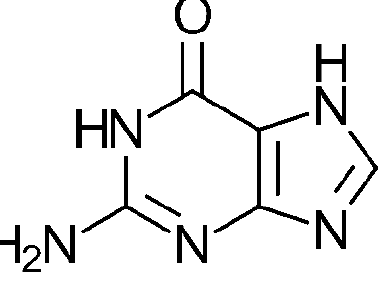
Figure 9. Structure of Guanine. Table 3. The gradual growth of guanine.